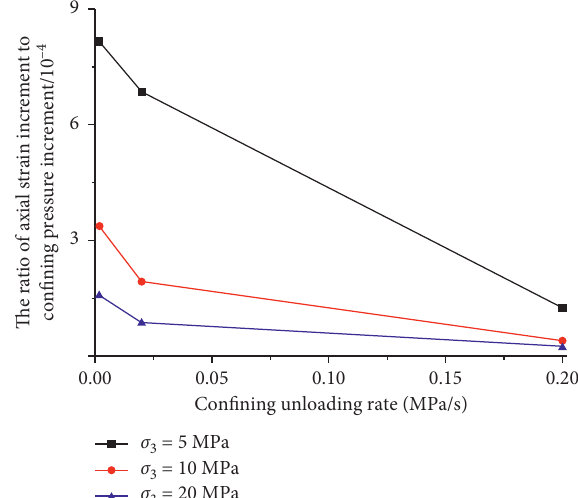
Figure 6: Relationships between Δ ε and unloading rates of confining pressure of